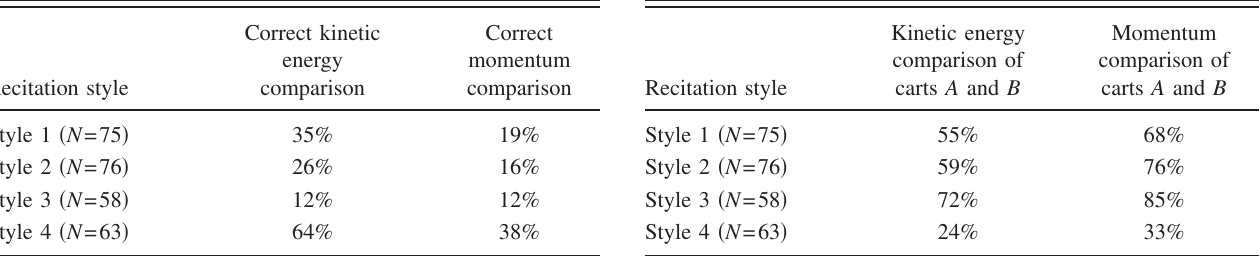
TABLE VI. Students who continued to use same incorrect rea- soning on pre- and post-test question